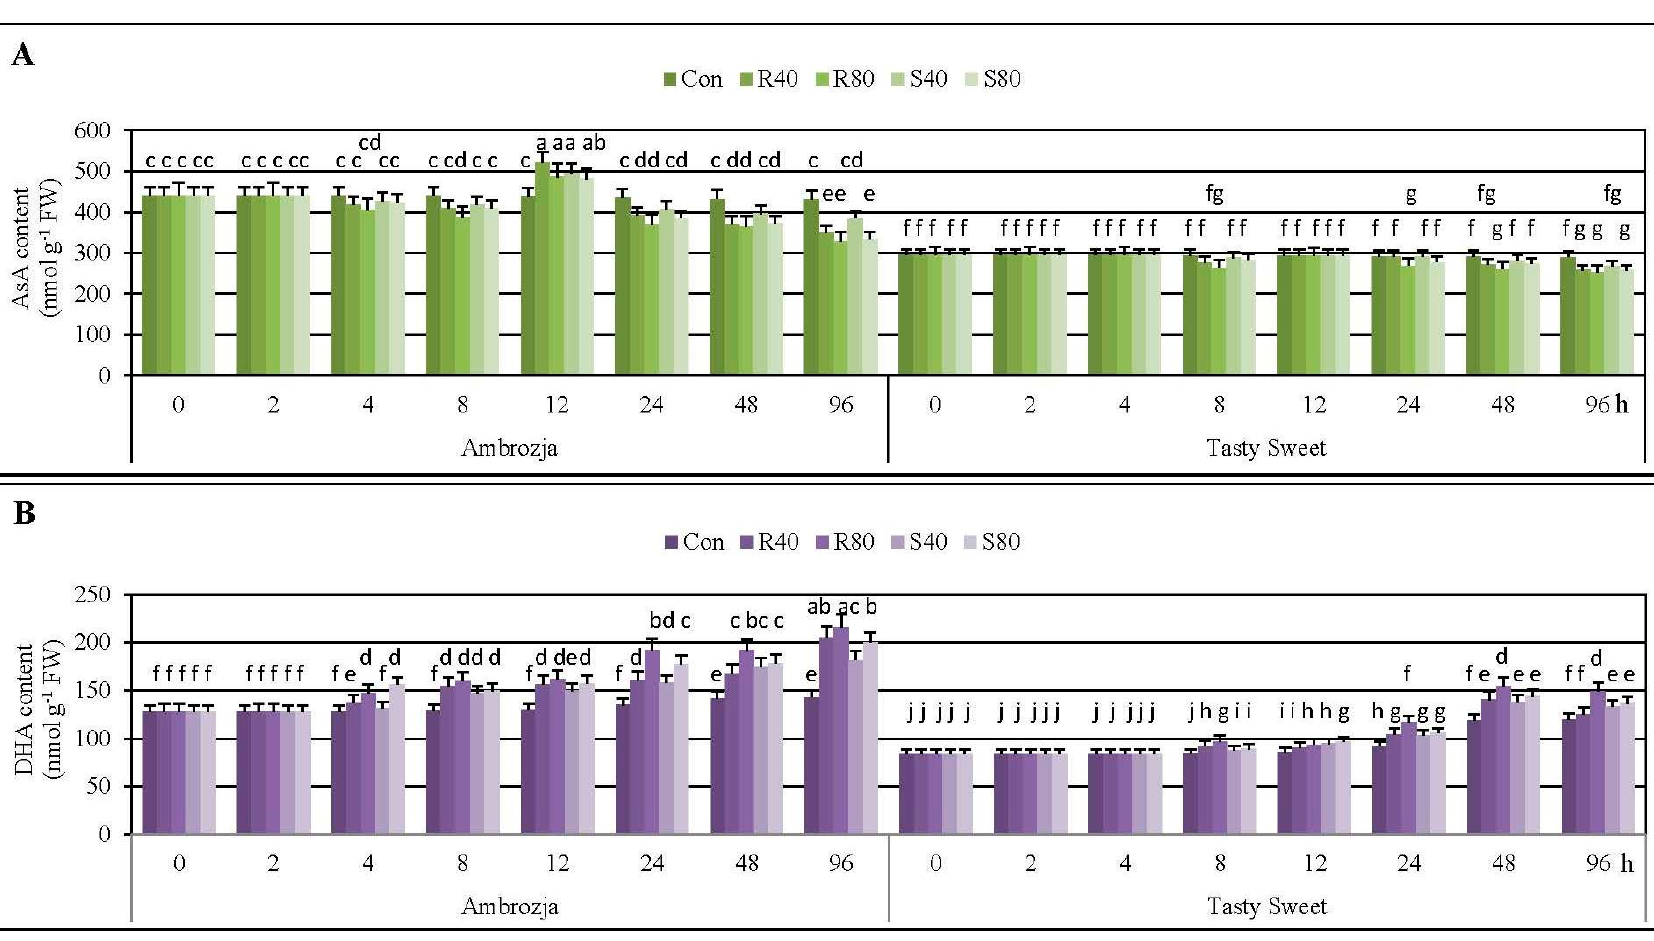
Figure 2. Influence of the cereal aphid’s infestation on the content of reduced ascorbate ‒ AsA ( A ); and oxidized ascorbate ‒ DHA ( B ) in the seedlings of Ambrozja and Tasty Sweet maize cultivars. R40, R80—maize plants of a certain genotype infested with 40 or 80 R. padi females per seedling, accordingly; S40, S80—maize plants of a certain genotype infested with 40 or 80 S. avenae females per seedling, respectively. All data are presented as the mean (±SD) of three independent biotests, and significant differences between tested groups of the maize plants are denoted by different letters ( p < 0.05; post-hoc Tukey’s test).